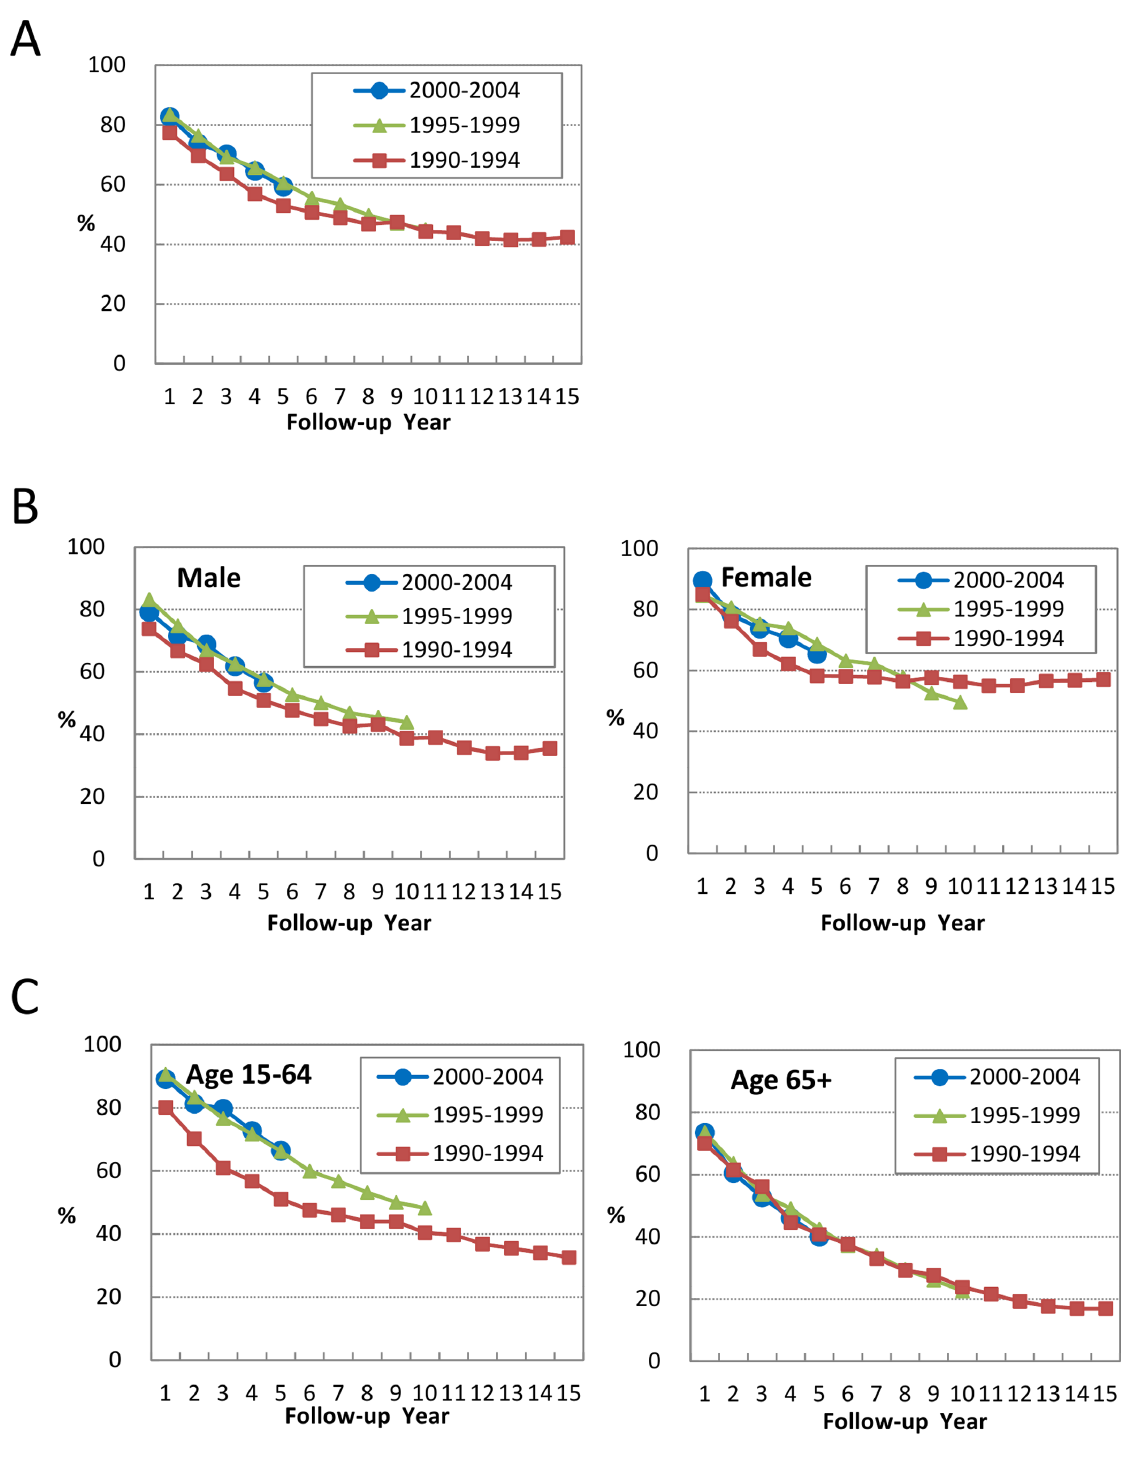
Figure 2. Relative survival curves of patients with CLL in different time periods in Taiwan: (A) for all patients, (B) between genders, and (C) between age groups.